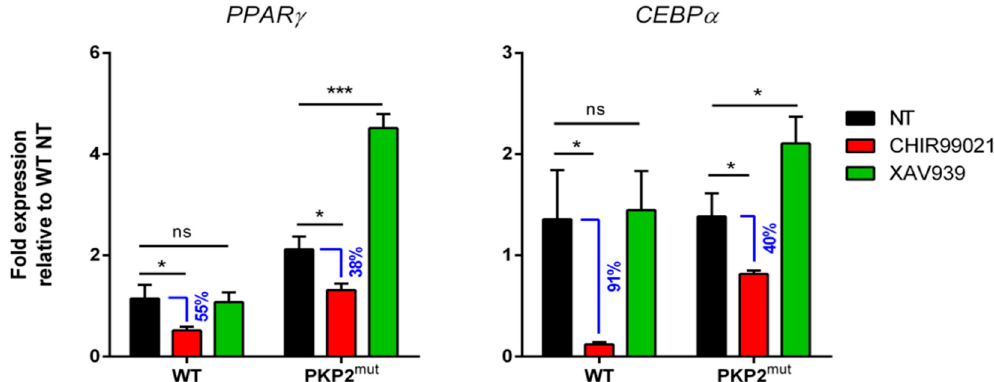
Figure 4. qRT–PCR analysis of PPAR γ and CEBP α in PKP2 mut and control cardiac myocytes (CMs) cultured in presence of canonical Wnt inhibitor (XAV939) and activator (CHIR99021).WT and PKP2 mut CMs treated with CHIR99021 (red bars) show a downregulation of the adipogenic master regulator genes, PPAR γ ( left panel ) and CEBP α ( right panel ), compared to their untreated counterpart. In agreement with the mathematical model, a higher difference of expression between untreated and treated cells was detected for the WT group and the relative percentage of expression is written in blue. XAV939 treatment (green bars) induces an upregulation of adipogenic genes in PKP2 mut cells only. n = 3; ns = Not significant. * p < 0.05, *** p < 0.001; t -test. Data are shown as means ± SEM; NT = not treated.